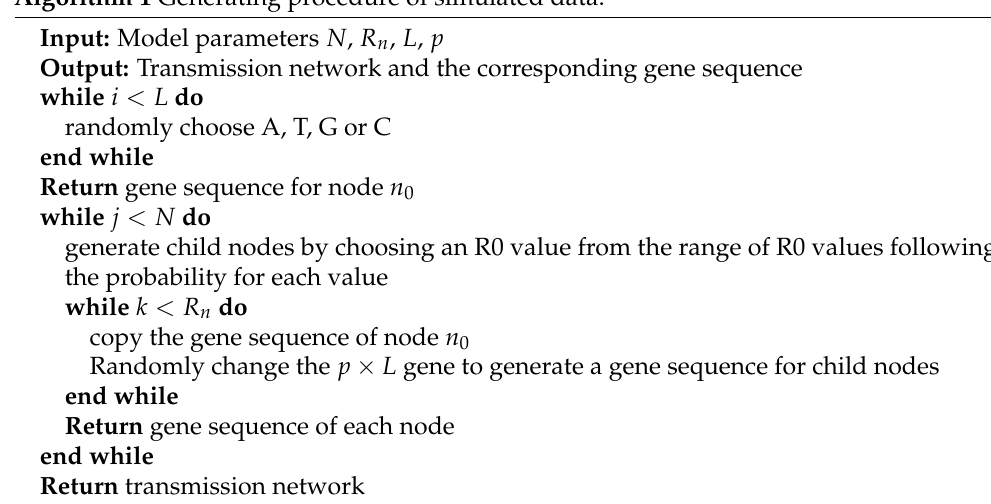
Algorithm 1 Generating procedure of simulated